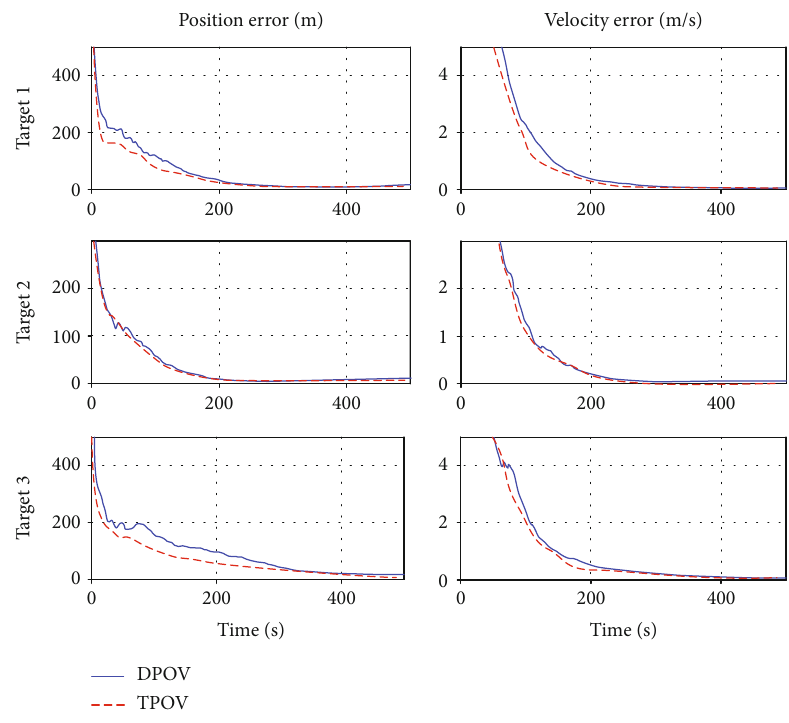
Figure 6: Position and velocity errors of targets 1, 2, and 3 for di ff erent observation methods.